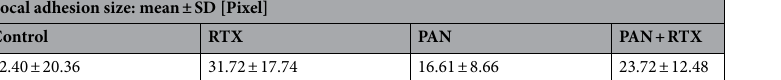
Table 5. Abberant size of focal adhesions in human podocytes is improved by rituximab. Quantification of focal adhesion size as a means of determining adhesion efficiency. RTX = rituximab (100